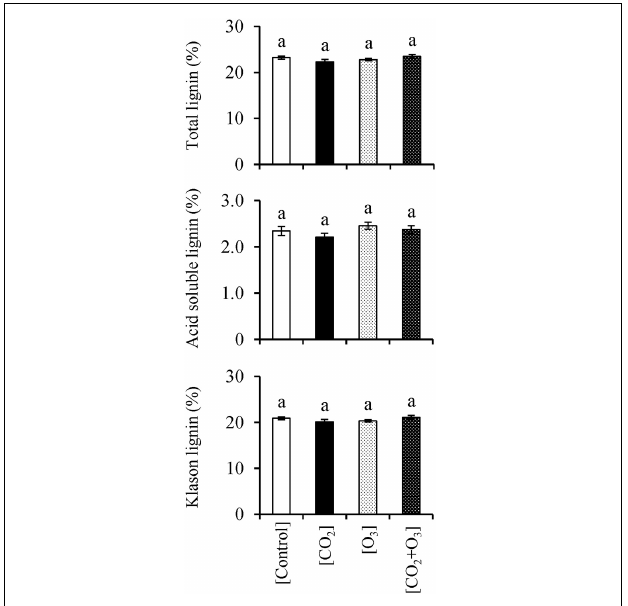
FIGURE 3 | Total lignin, acid-soluble lignin, and Klason lignin contents in Q. mongolica seedlings subjected to conditions of atmospheric CO 2 and O 3 concentration ([Control]), elevated CO 2 concentration ([CO 2 ]), elevated O 3 concentration ([O 3 ]), and a combination of elevated CO 2 and O 3 concentrations ([CO 2 + O 3 ]). Bars indicate standard errors. Different letters indicate significant differences among treatments (Tukey method: p < 0.050).